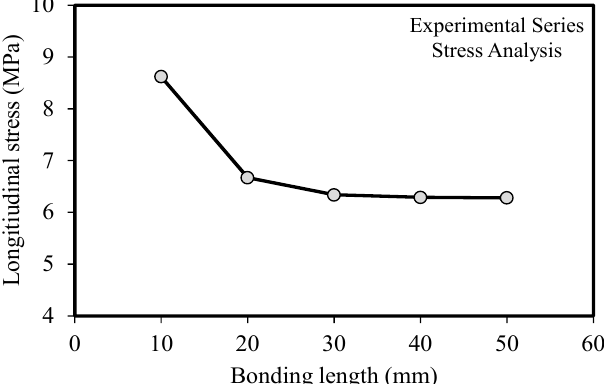
Figure 8. The variation of critical longitudinal stress for different bonding lengths (applied stress for all the specimens: 1000 MPa).